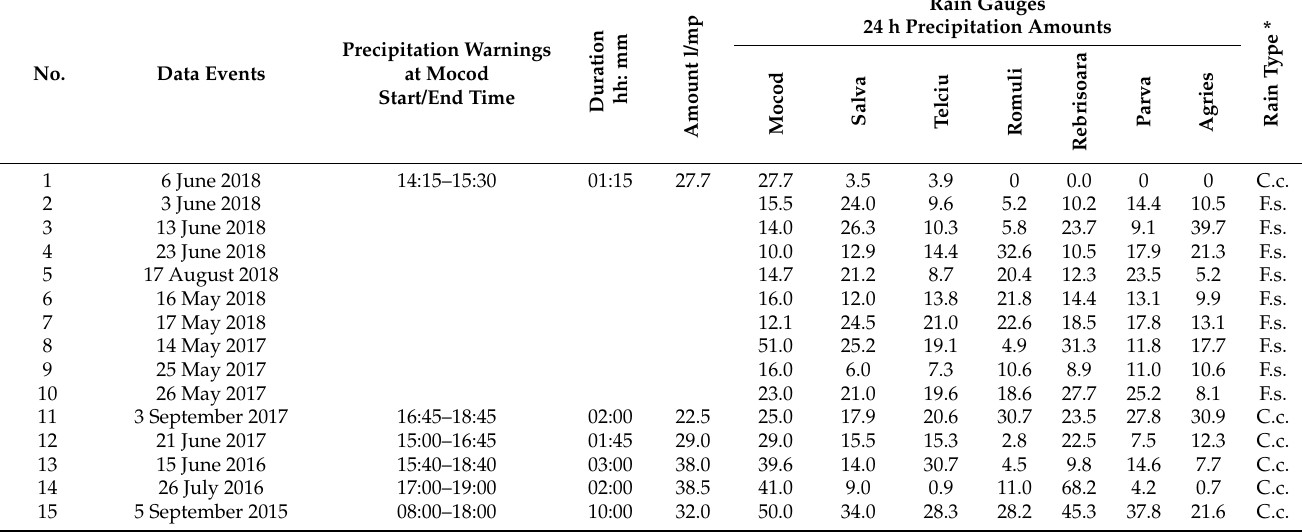
Table 1. Rainfall events between 2015–2018.